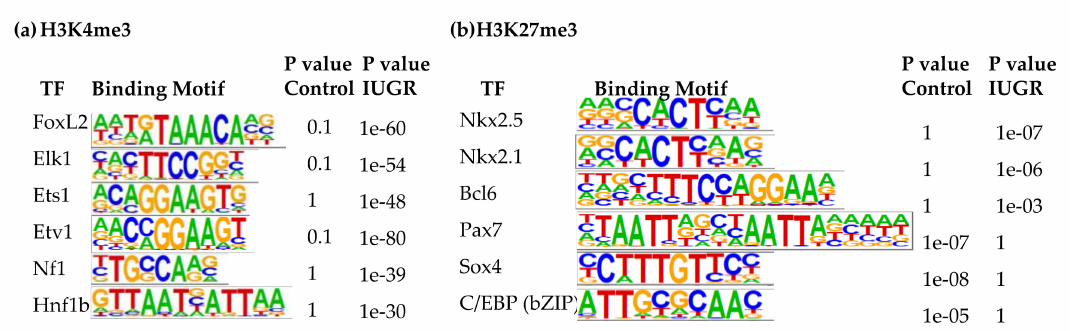
Figure 4. Transcription factor binding motifs enriched in islets at 2 weeks of age. ( a ) H3K4me3; ( b )